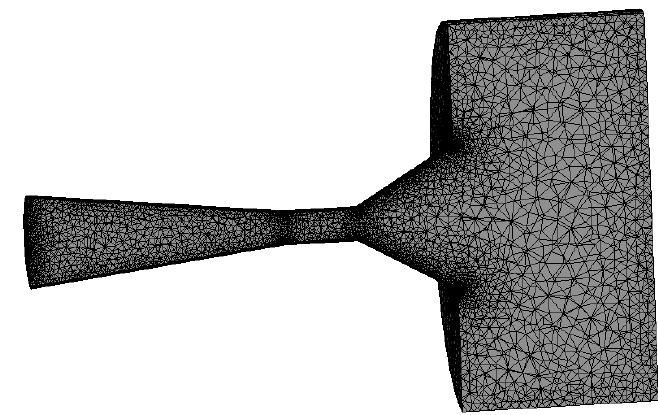
Figure 6. Mesh independence analysis.